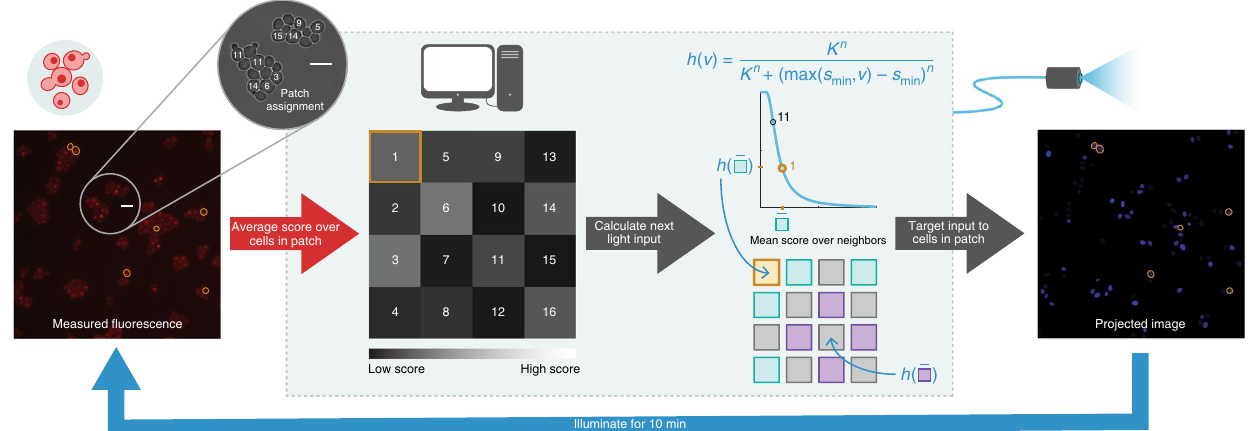
Fig. 4 Schematic of automated work fl ow for patterning experiments. Cells growing in a monolayer were placed under the microscope, which was connected to a computer system that controlled the camera and blue light projection system. Cells were segmented and tracked in bright fi eld images and scored in fl uorescence images (here, false-colored red). After the fi rst image was acquired, cells were randomly assigned to patches to which they belonged for the remainder of the experiment. The grid visualizes scores at a single time step, with each square representing one patch of cells. The brightness of a square corresponds to the average score of the constituent cells in the corresponding patch. The signaling relation, de fi ned before experiment start, determined the input light intensity administered to patches for the next time step (10 min) based on the scores of neighboring patches to the north, south, east, and west, with periodic boundary conditions. The relation h ( ⋅ ) was chosen to be an inhibiting Hill function with a minor correction to better utilize the range of available illumination intensities (i.e., a patch received maximum illumination intensity if the average score over its neighbors was at or below s min = 0.05). The Hill coef fi cient was fi xed at n = 2 for all experiments. The bifurcation parameter K was fi xed for each experiment at a value between 0.1 and 1. Cells in the same patch received the same input intensity targeted individually to each cell, as shown in the projected image. Scale bar in fl uorescence and bright fi eld images is 10 μ